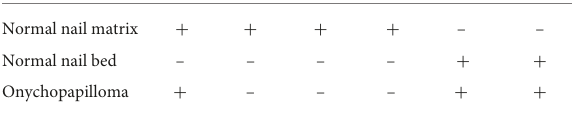
TABLE 2 Hair-related keratins and epithelial keratins expression in the normal nail unit and onychopapilloma.